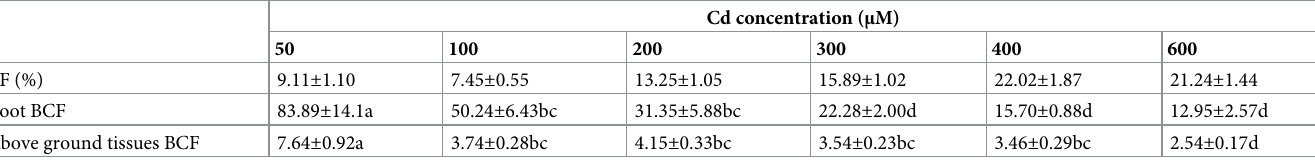
Table 1. Bio-concentration factor (BCF) and translocation factor (TF) of Cd in S . portulacastrum .